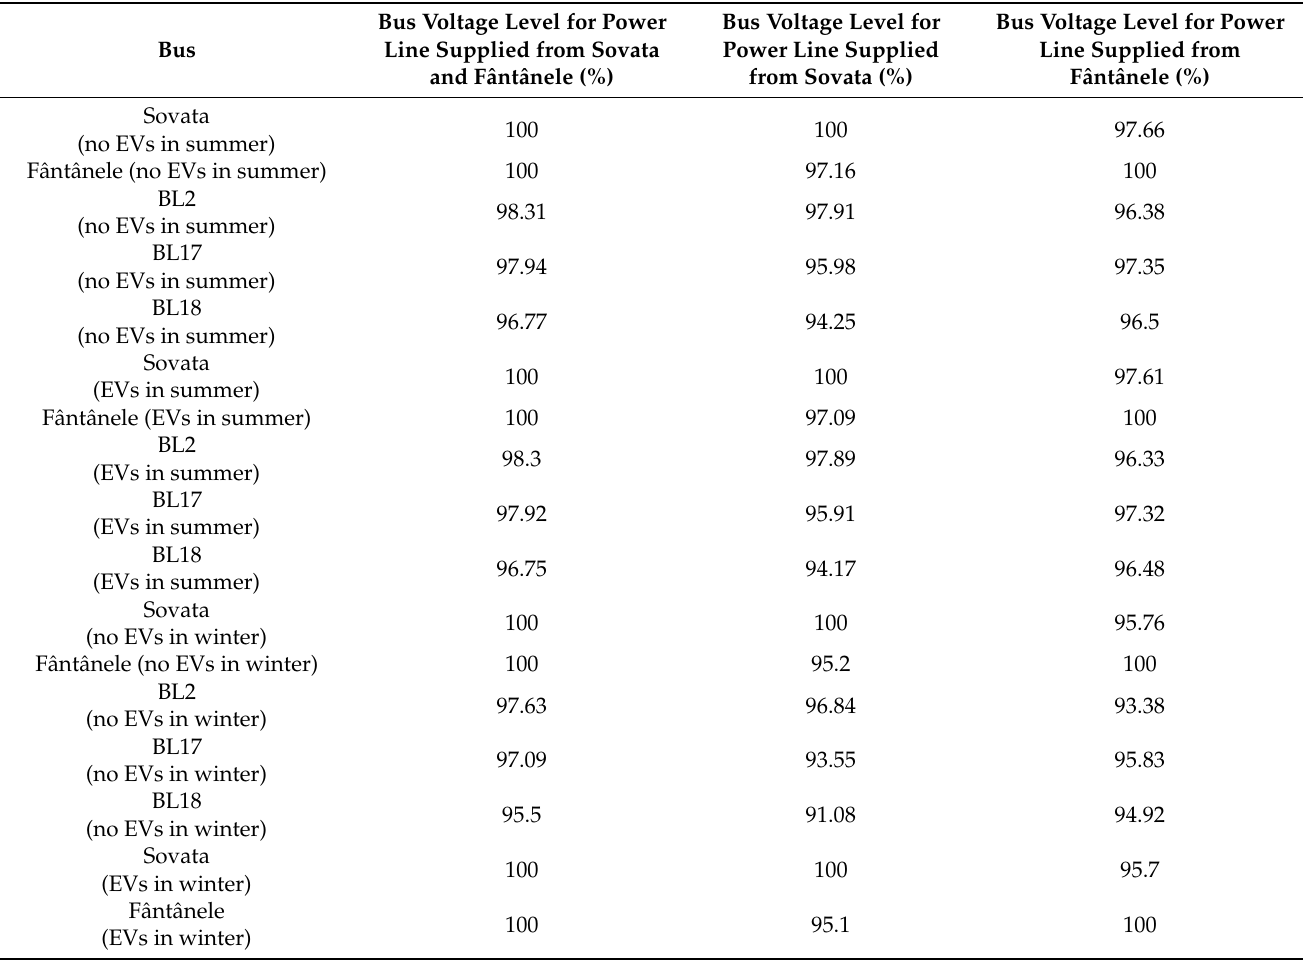
Table 15. Voltage level at 6:00 (scenario